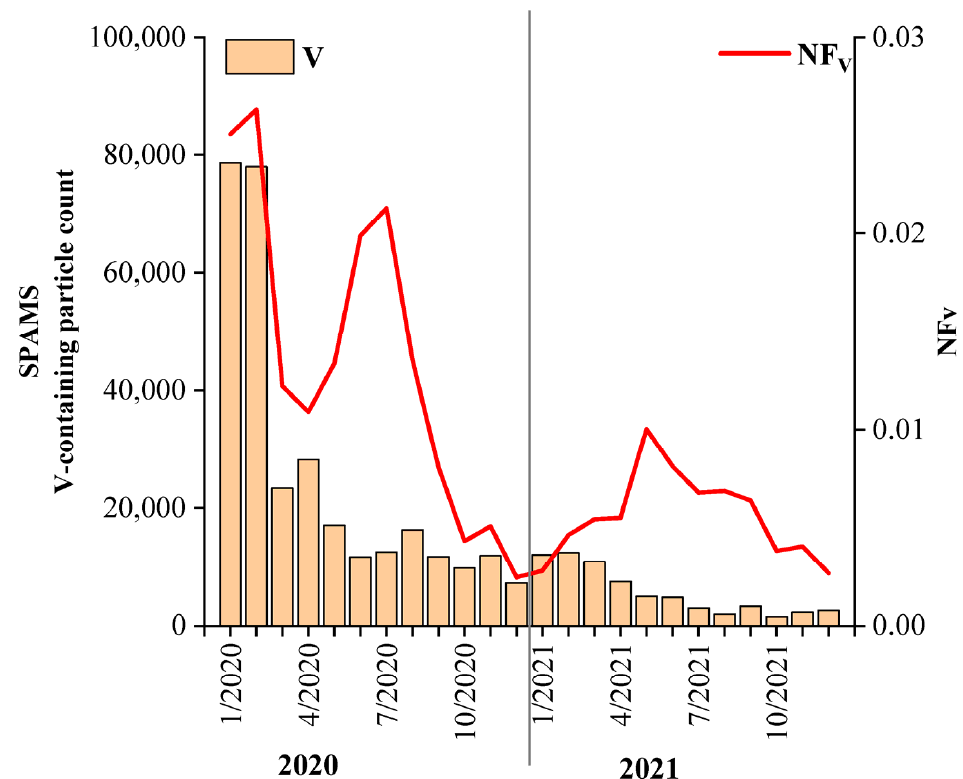
Figure 2. Variation trend of the number of V-containing particles and their proportions of the total particles in each month measured via SPAMS in Guangzhou, China, from 2020 to 2021.